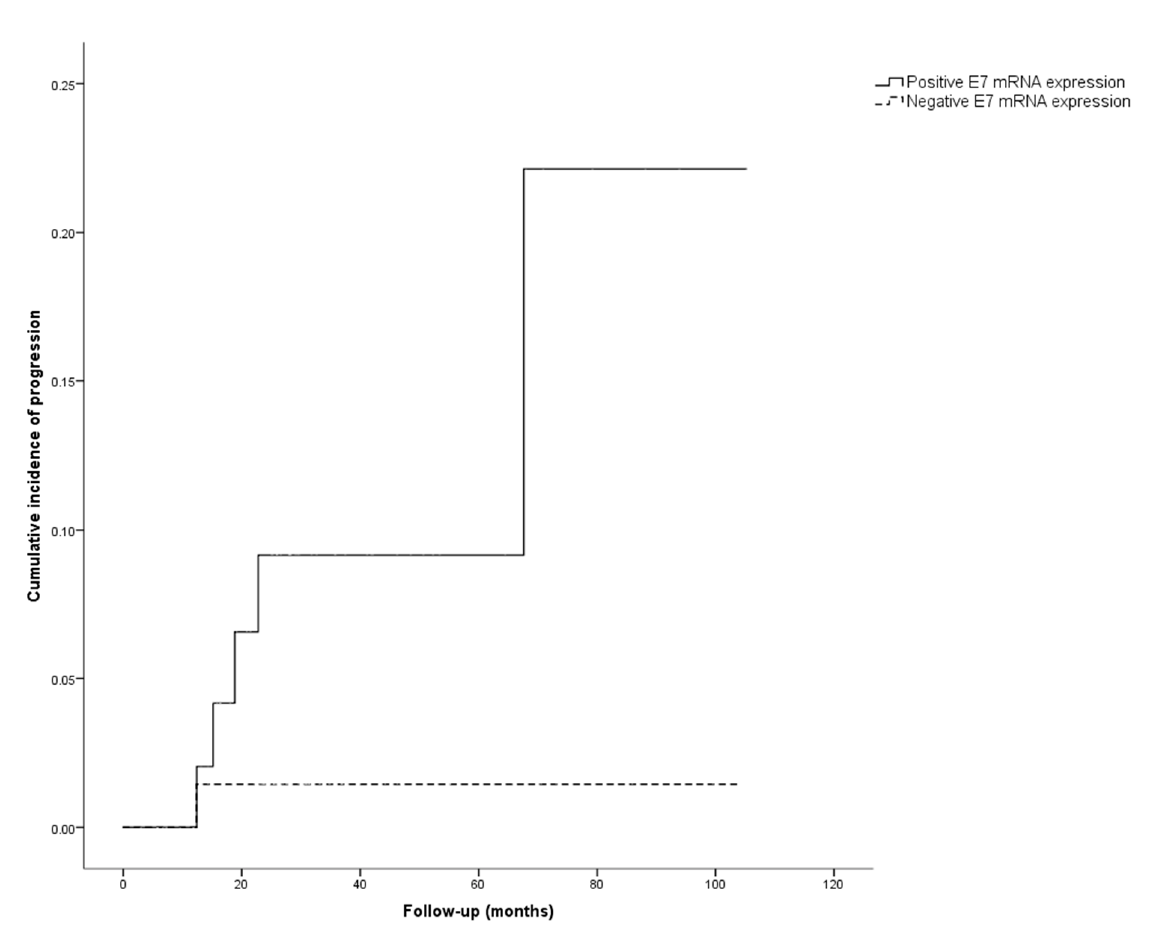
Figure 1. Cumulative incidence of progression to HSIL/CIN2+ in cases with positive HPV16 E7 mRNA expression (solid line) vs. cases with negative HPV16 E7 mRNA (dashed line).